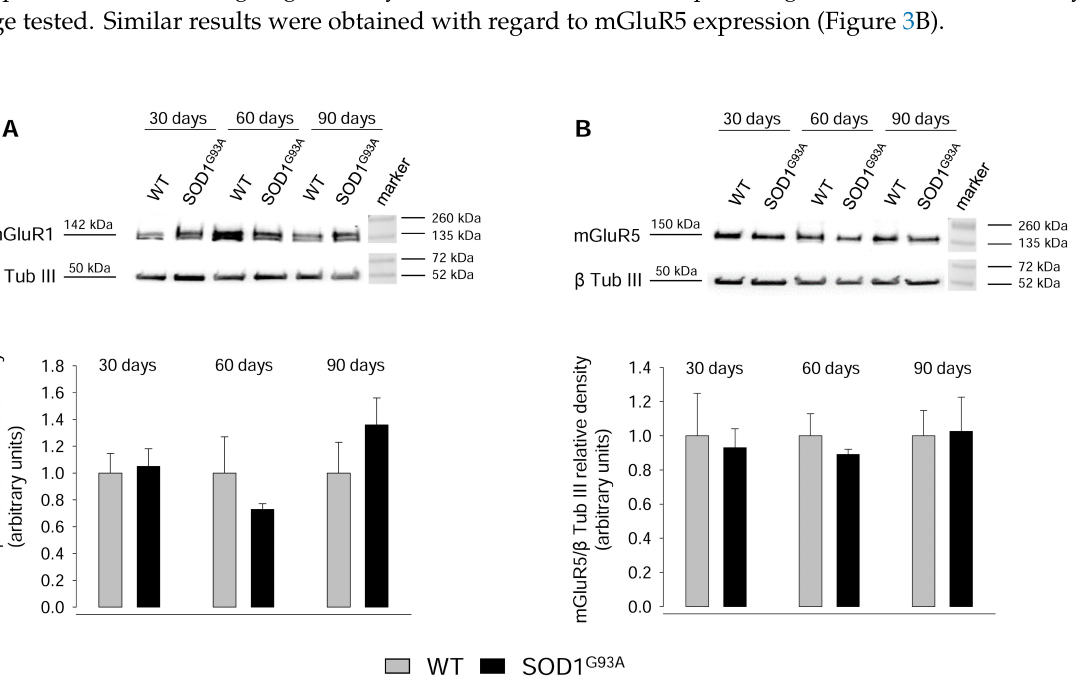
Figure 3. mGluR1 and mGluR5 expression in spinal cord synaptosomes from WT and SOD1 G93A mice. SOD1 G93A mice were sacrificed at postnatal day 30, 60, and 90 days. Age-matched WT mice were